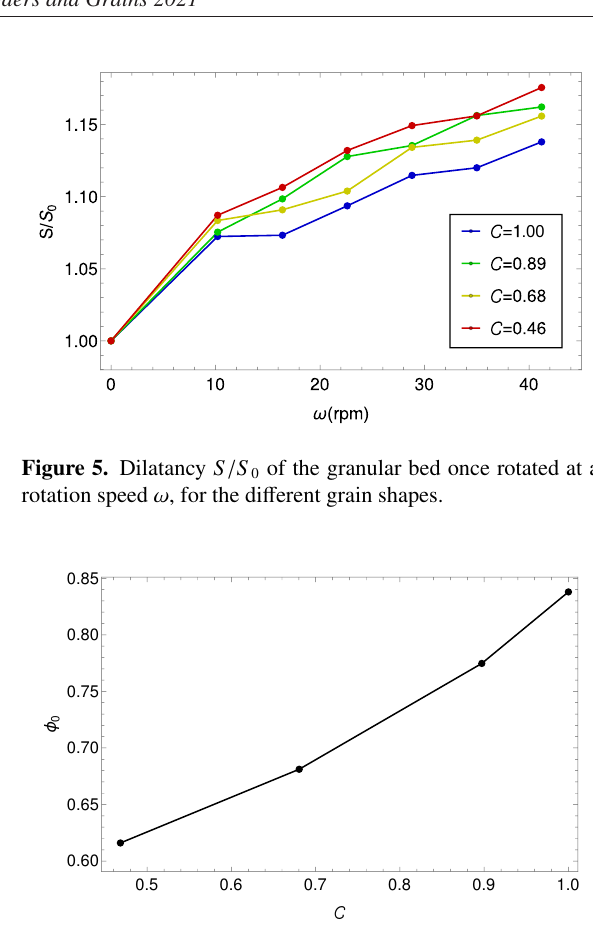
Figure 6. Packing fraction at rest φ 0 of the di ff erent shapes de- fined by their circularity C